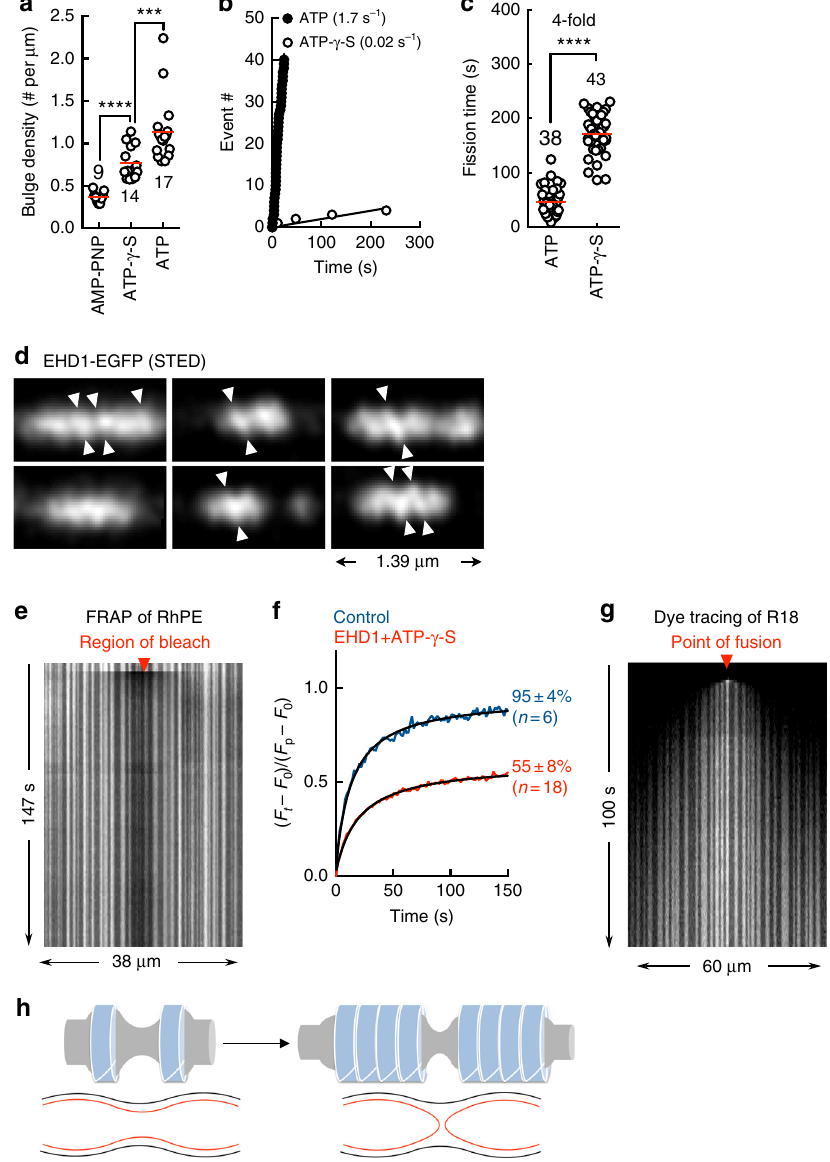
Fig. 7 Intermediates in the membrane-remodeling pathway. a Bulge density per unit length of the tube upon addition of EHD1 with AMP-PNP, ATP- γ -S and ATP for the indicated numbers of tubes. Red line denotes the mean. Statistical signi fi cance was assessed using Mann – Whitney ’ s two-tailed test and *** P < 0.005, **** P < 0.0001. b Plot showing cumulative cuts seen as a function of time ( fi ssion rate) upon adding EHD1 with ATP or ATP- γ -S to a collection of tubes. c Plot showing the time interval between membrane bulging and scission ( fi ssion time) upon adding EHD1 with ATP or ATP- γ -S to tubes for the indicated numbers of events. Red line denotes the mean. Statistical signi fi cance was assessed using Mann – Whitney ’ s two-tailed test and **** P < 0.0001. d STED microscopic images of EHD1-EGFP scaffolds with ATP- γ -S. White arrowheads mark the possible orientation of helical rungs. e Representative kymograph showing FRAP of an RhPE-containing tube displaying EHD1 scaffolds with ATP- γ -S. f Fluorescence recovery kinetics of RhPE for the indicated conditions. Numbers represent mobile fraction (mean ± SD for n (tubes) as indicated). g Representative kymograph showing fusion and spreading of R18 on a tube displaying EHD1 scaffolds with ATP- γ -S. h Schematic showing growth-induced tube thinning leading to the formation of a hemifused intermediate. Black and red lines depict the outer and inner monolayers, respectively of the